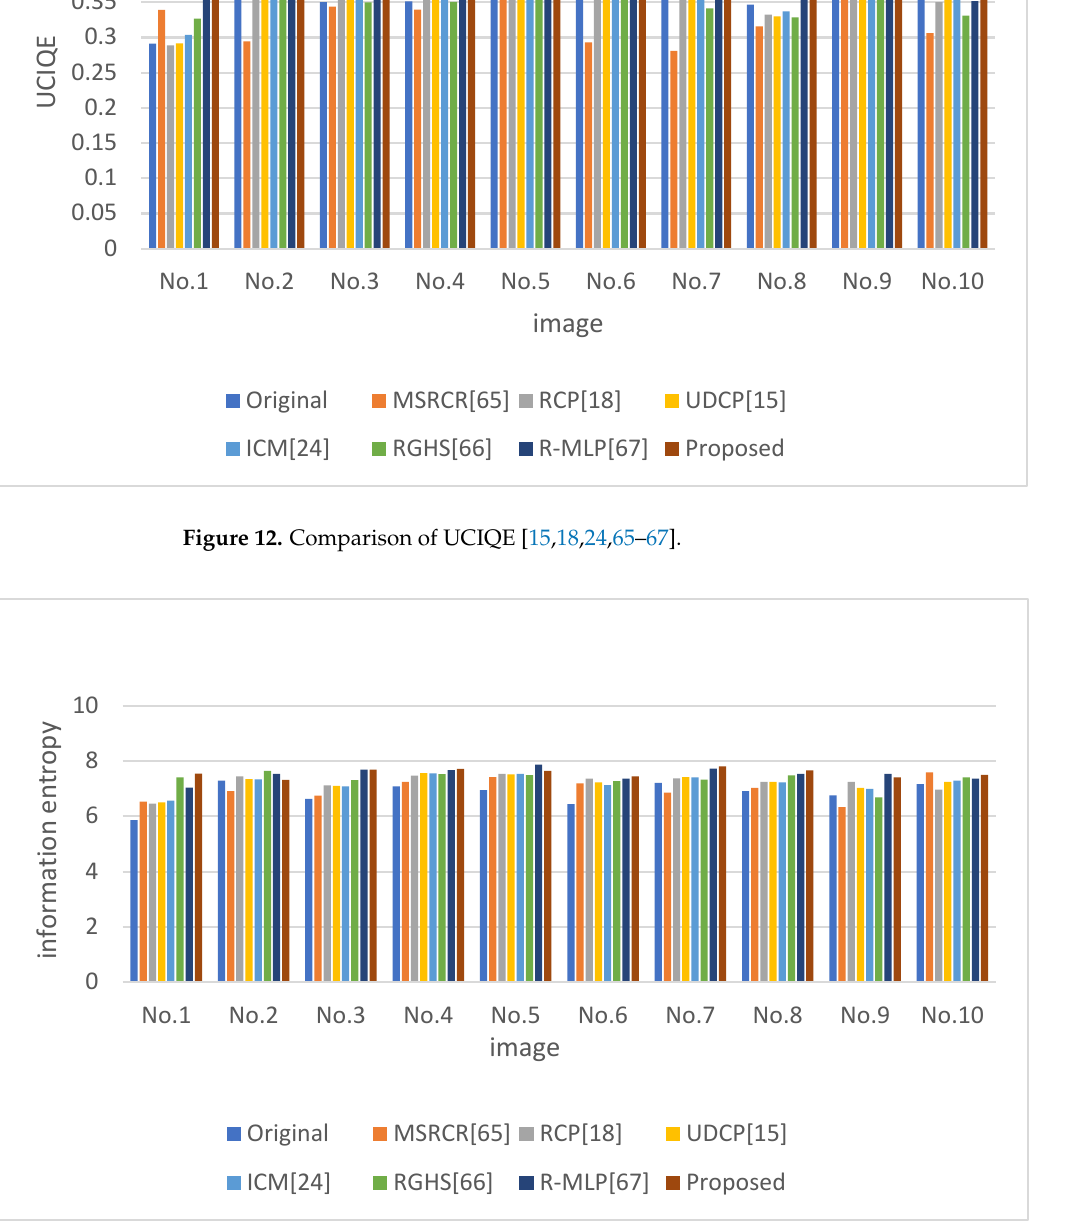
Figure 13. Comparison of information entropy [15,18,24,65–67]. As can be recognized from the comparison results, in terms of RMS contrast and aver- age gradient, the proposed method obviously and exclusively gains better enhancement than the other algorithms. In terms of UCIQE, the proposed method generally outperforms the others, with three exceptions in image No.4 by R-MLP, in image No.5 by ICM, and in image No.6 by RCP. Similarly, in terms of information entropy, the proposed method generally outperforms the other algorithms, with four exceptions in image No.2 by RGHS, in images No.5 and No.9 by R-MLP, and in image No.10 by MSRCR. Nevertheless, it is noted that in these four exceptions the proposed method still performs